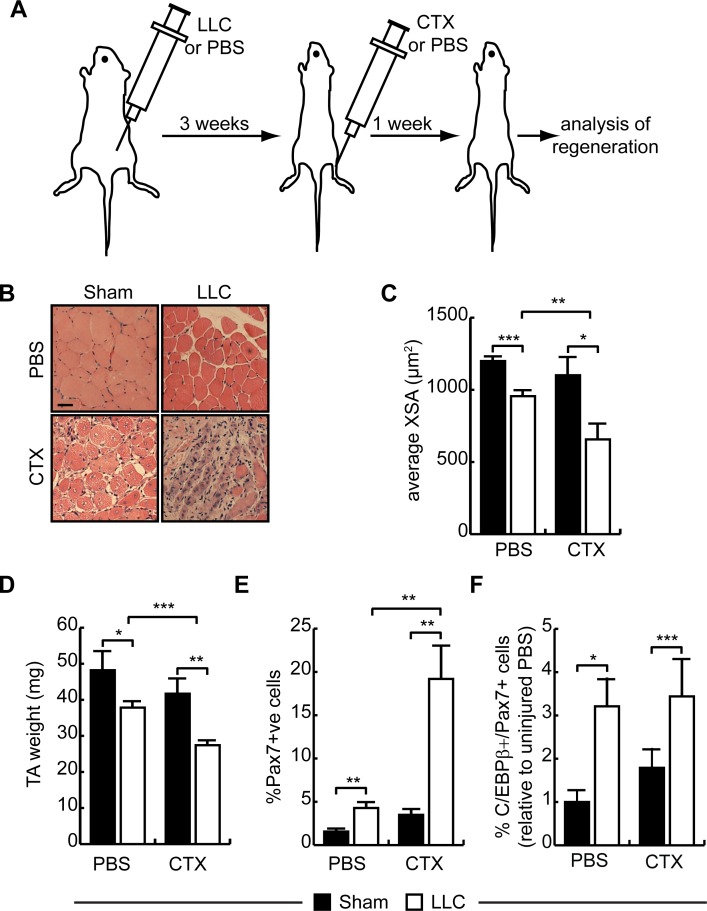
Defective muscle regeneration in cachectic animals after acute injury.
(A) Schematic representation of the injury model. Cachexia was induced by engrafting LLC cancer cells subcutaneously and allowing them to grow for 3 weeks. Once cachexia was established, animals were injured by injecting cardiotoxin (CTX) into the TA muscle. Sham injury was achieved using PBS. Injury was allowed to repair for one week before analysis. (B) H&E-stained TA cross-sections from sham and LLC-injected mice as in (B) 7 days after CTX injury. The contralateral TA was injected with PBS alone. Scale bar = 20μm. (C) Average fiber XSA of PBS and CTX-injured sham and LLC mice as in (B). *p<0.05, **p<0.01, ***p<0.001, n = 4. (D) TA mass in PBS and CTX-injured sham and LLC mice as in (B). *p<0.05, **p<0.01, ***p<0.001, n = 5. (E) Percentage of Pax7+ cells (relative to total DAPI+ nuclei) in PBS and CTX-injured TA of sham and LLC animals. **p<0.01, ***p<0.001, n = 5. (F) Percentage of C/EBPβ+/Pax7+ cells (relative to uninjured sham animals) in PBS and CTX-injured TA of sham and LLC animals. *p<0.05, ***p<0.001, n = 3.